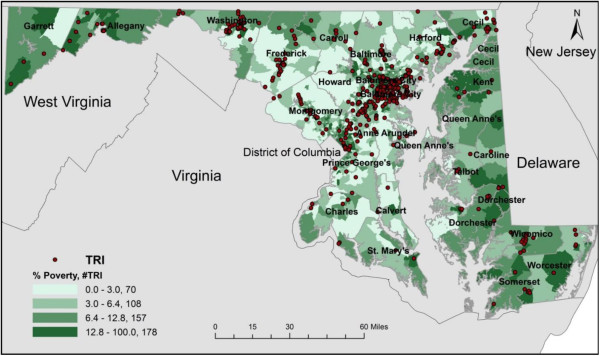
Choropleth map of TRI facilities in Maryland by quartiles for percent poverty (2010 US census).